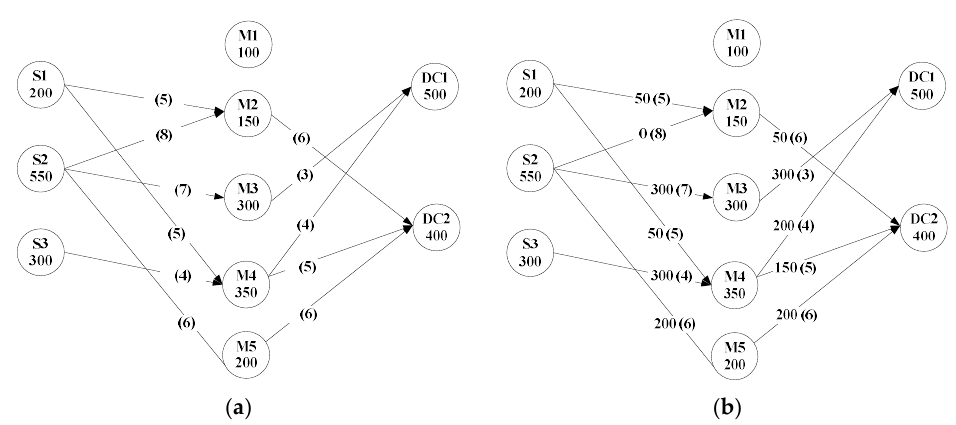
Figure 4. The first two sections of chromosome in stage 1.